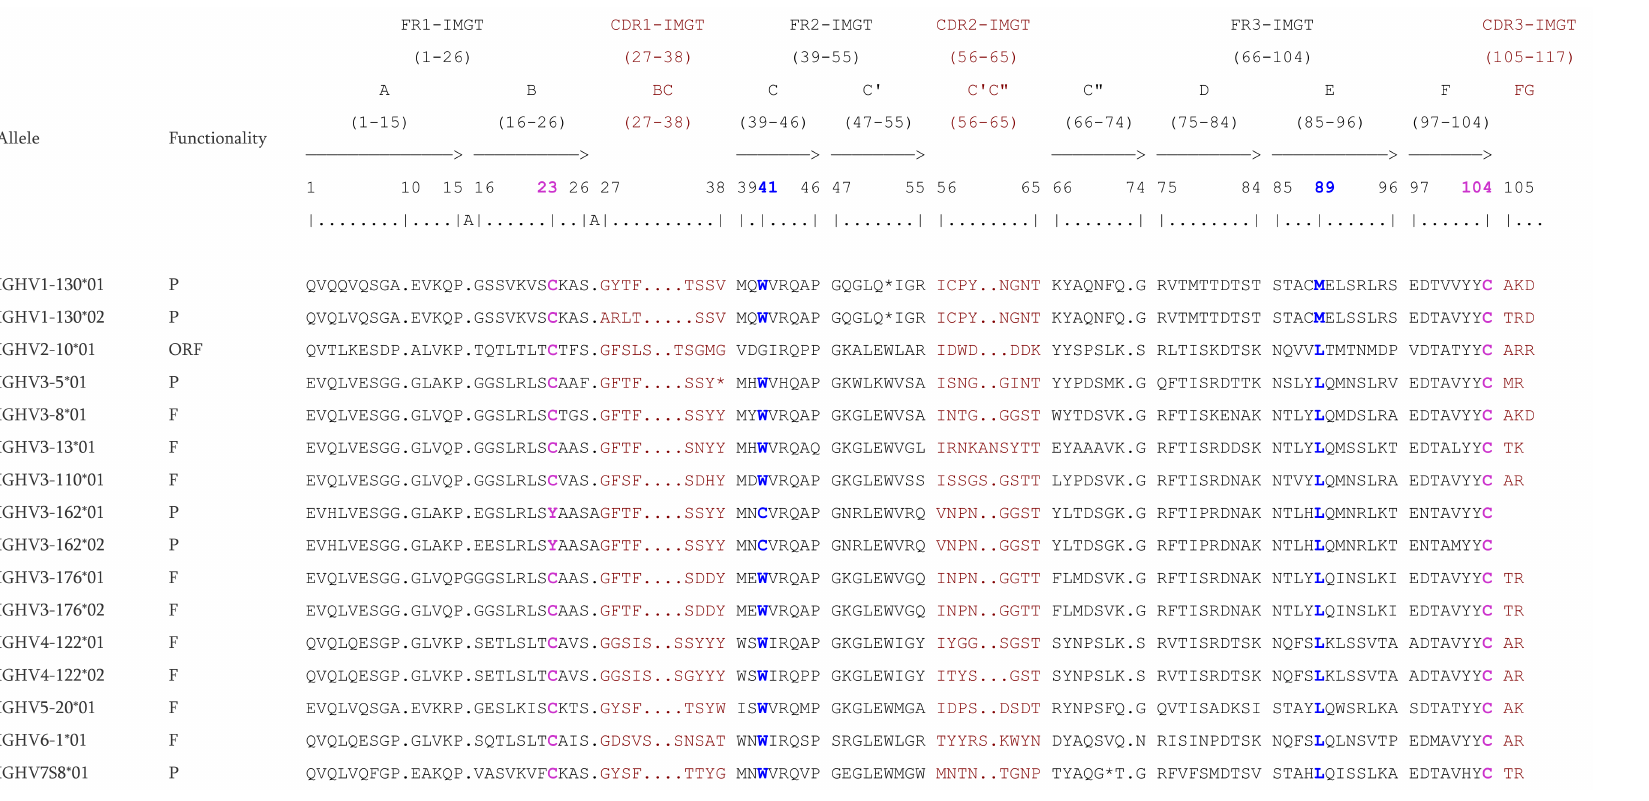
Figure 2. IMGT Protein display of the Macaca mulatta (rhesus monkey) IGHV genes. Only a few functional genes, ORF and in-frame P are shown as examples. The outline of the CDR-IMGT and FR-IMGT are according to the IMGT unique numbering for V-REGION [70]. The four conserved amino acids are shaded in pink for the C23 and C104, blue for the W41 and hydrophobic AA 89. * indicates in frame STOP-CODON. The CDR-IMGT are shaded in maroon while the FR-IMGT are in black. Data available in IMGT Repertoire (IG and TR) http://www.imgt.org/IMGTrepertoire/, accessed on 11 November 2021 > Proteins and alleles > Protein displays > V-DOMAIN > IGHV > Rhesus monkey ( Macaca mulatta ) or IMGT DomainDisplay http://www.imgt.org/3Dstructure-DB/cgi/DomainDisplay.cgi, accessed on 11 November